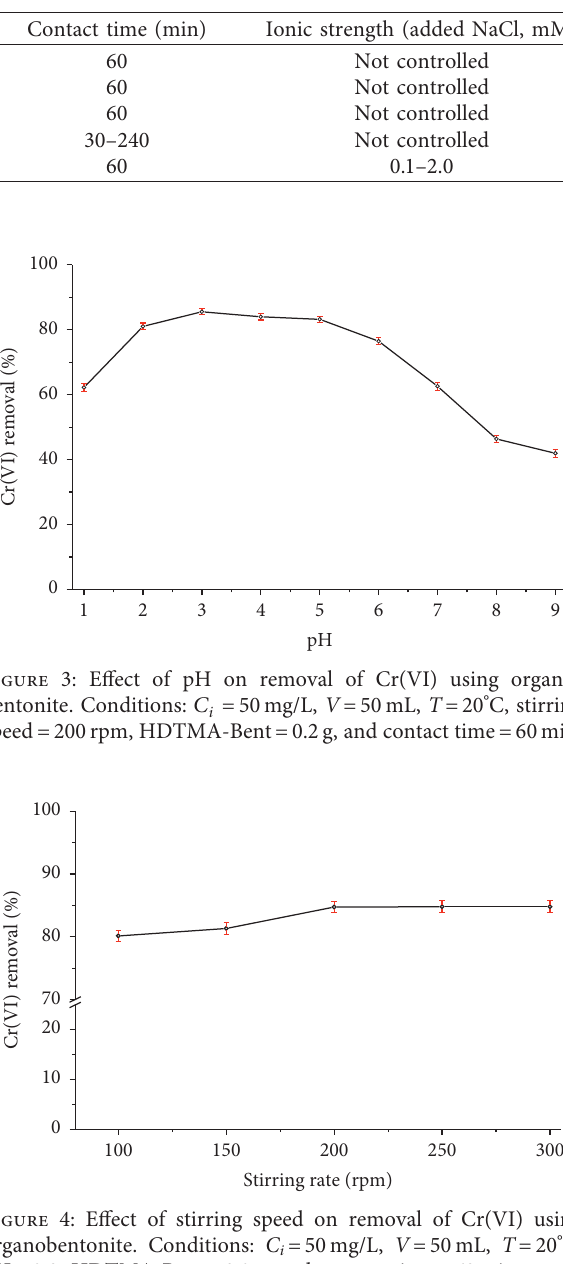
Table 1: Experimental conditions for the initial adsorption tests of Cr(VI) in aqueous solution.